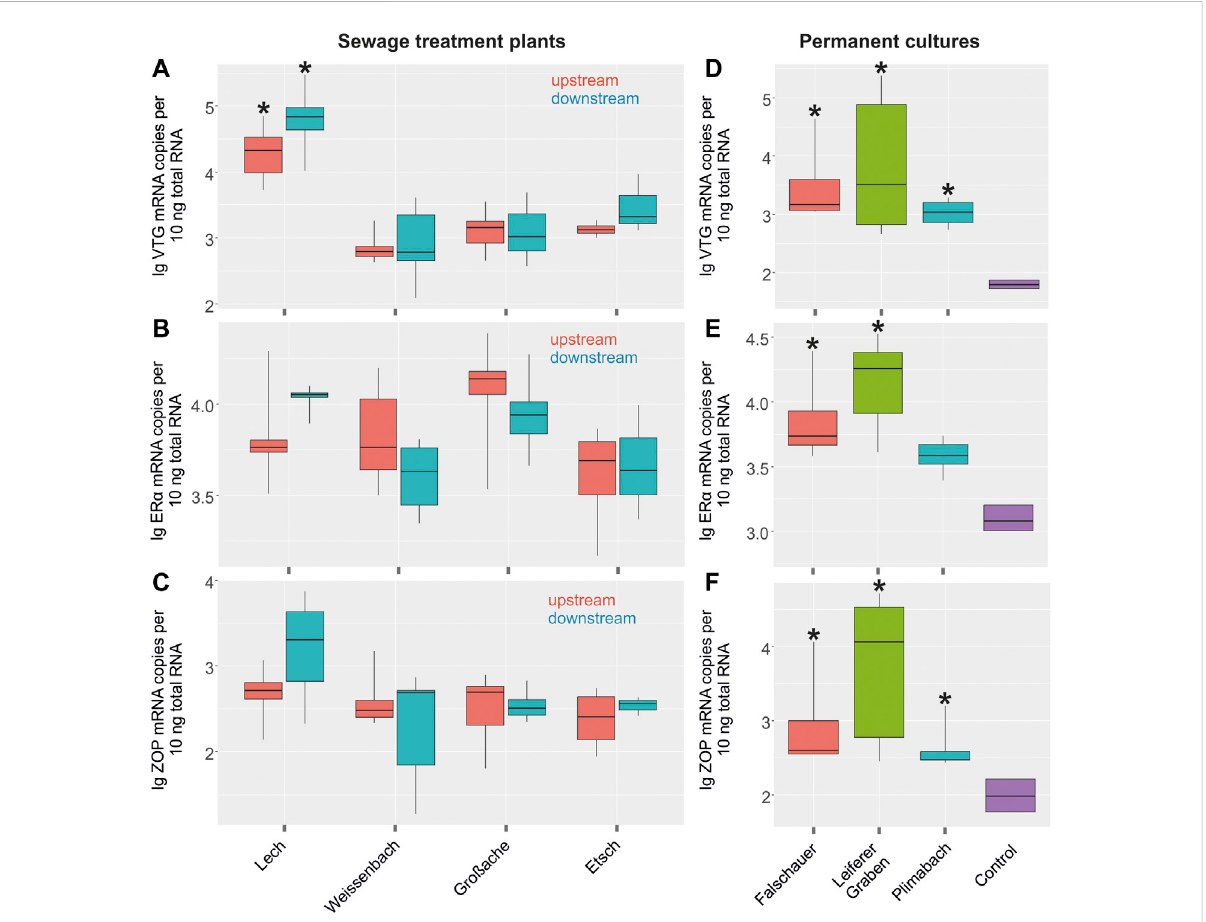
FIGURE 3 Log transformed expression levels (mRNA copy numbers per 10 ng total RNA) of (A) vitellogenin (VTG), (B) estrogen receptor α (ER α ), (C) zona pellucida (ZOP) in liver tissues of control individuals upstream of a sewage treatment plant (red) and individuals downstream the sewage treatment plant(turquoise)inindividualsof C.gobio .Asterisksindicateasigni fi cantdifferencetoothersamplingsitesofthestudy(signi fi cancelevel < 0.05).Log transformedexpressionlevels(mRNAcopynumbersper10 ngtotalRNA)of (D) VTG, (E) ER α , (F) ZOPinlivertissuesofcontrolindividualsfroma laboratory culture (lilac) andindividualsfrom permanentcultures(red,greenand turquoise).Asterisksindicate asigni fi cantdifference tothecontrols (signi fi cance level <